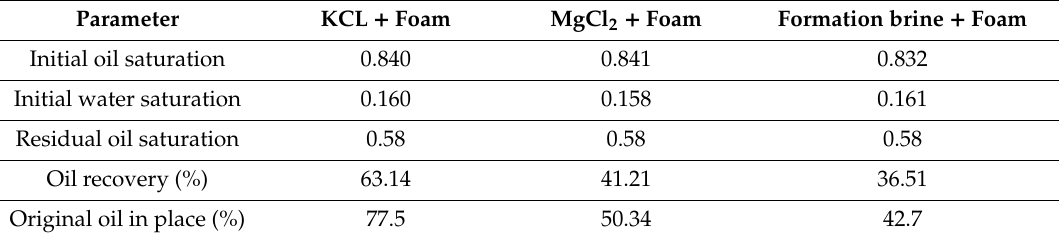
Table 2. Summary of